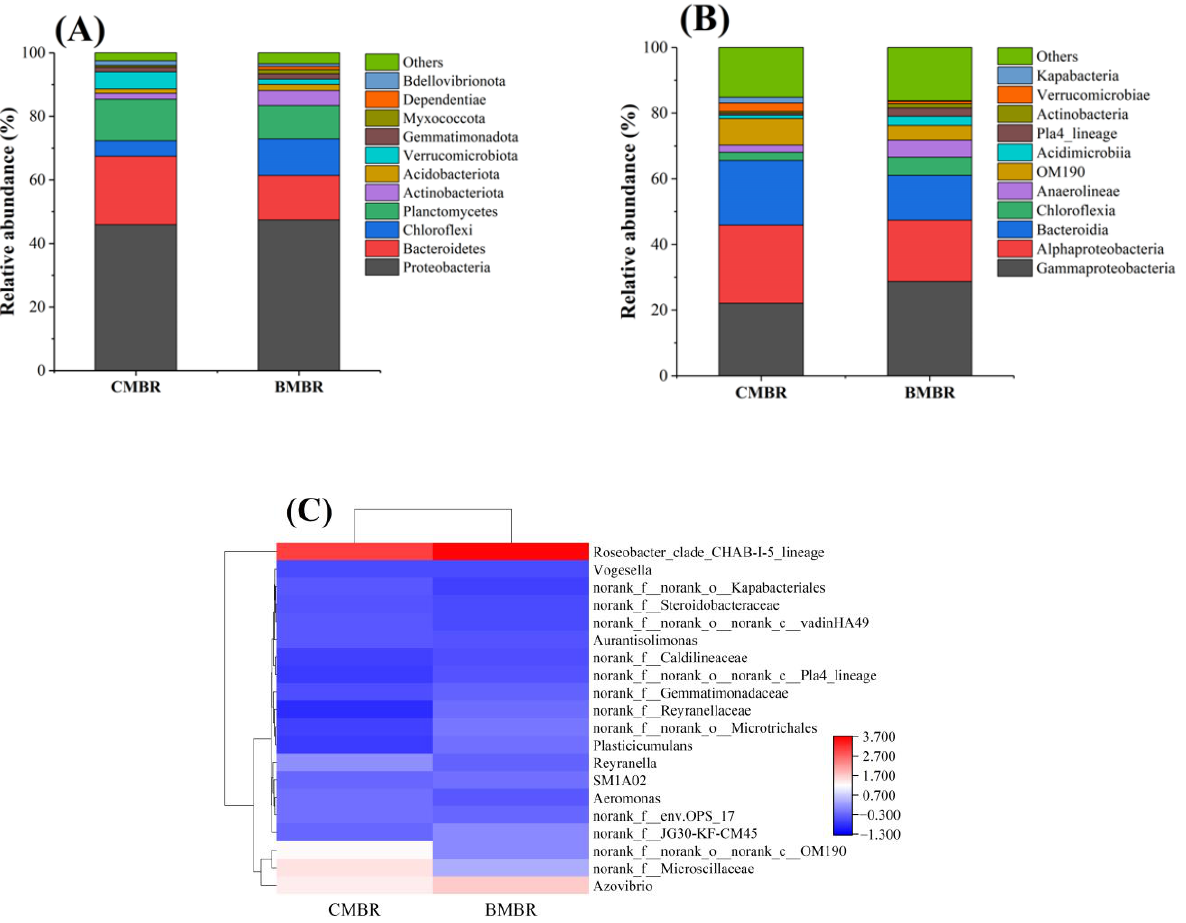
Figure 6. Microbial communities in the mixed-liquor suspension from conventional MBR (CMBR) and biochar MBR (BMBR) at ( A ) phylum ( B ) class and ( C ) genus level.